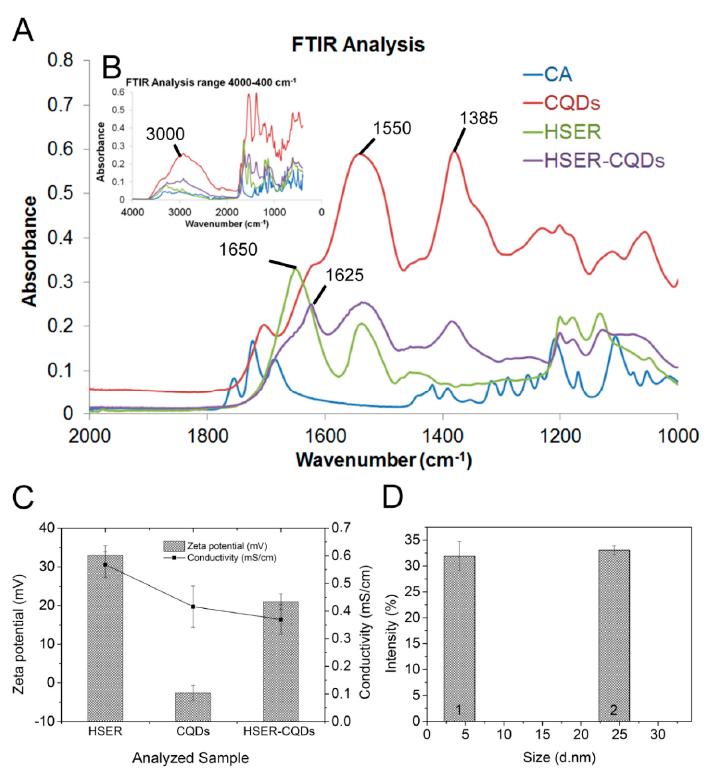
Figure 3. ( A ) FTIR analysis of citric acid (CA), carbon quantum dots (CQDs), peptide (HSER), and peptide-coated CQDs (HSER-CQDs) in the range 2000–1000 cm − 1 . The amide I region shows an increased peak at 1625 cm − 1 as a result of HSER interaction with CQDs; shouldered with a lower peak at 1650 cm − 1 . The former peak in amides indicates short-range hydrogen bond interactions, while the latter indicates long range hydrogen bond interactions. ( B ) Complete FTIR spectra for the range 4000–400 cm − 1 . A clear and broad band around 3000 cm − 1 correlates with the hydroxyl group. The overall decrease of CQDs vibrations (red line) confirms successful coating by HSER peptide in the complex HSER-CQDs (purple line). ( C ) The zeta potential of HSER, CQDs and HSER–CQDs, and ( D ) the zeta size of the CQDs is marked as 1 and HSER–CQDs is marked as 2. Data represent the mean ±SD, n = 5. However, the particle size distribution showing average particle size and the zeta potential of the prepared HSER–CQDs were analyzed using DLS after purification, using dialysis in D-Tube maxi dialyzer tubes against Mili-Q (Figure 3C,D). Thereafter, the formation of nanoparticles was also confirmed by zeta size and potential measuring. Zeta size results obtained indicates that the size of CQDs is 4 ± 2 nm, while the size of HSER-CQDs was found to be 23 ± 3 nm (Figure 3D). Furthermore, the value of the zeta potential showed that the lowest zeta potential was found in case of CQDs at − 3 mV, and the highest zeta potential show HSER with 33 mV. Finally, the HSER-CQDs conjugate reveal the change of zeta potential after interaction to be 23 mV, showing the tendencies to aggregate which can be connected with peptide aggregation on the surface of nanoparticles. Thus, after the